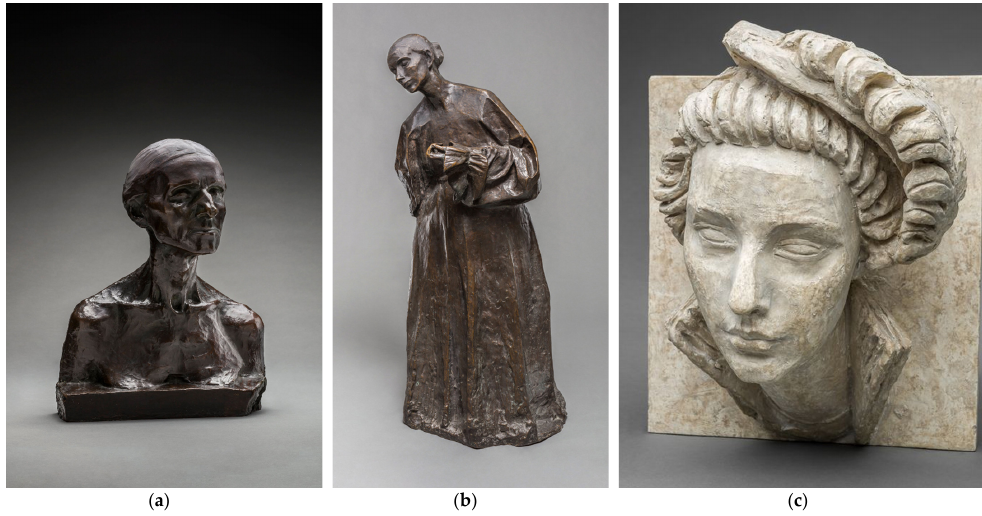
Figure 8. Xawery Dunikowski, sculptures: ( a ) “Mother”, 1899; ( b ) “Pregnant women III”, 1906; ( c ) Female Head from the cycle of the “Wawel Heads”, 1925–1929 (National Museum in Warsaw, Królikarnia, photo Ernest Wi ń czyk).